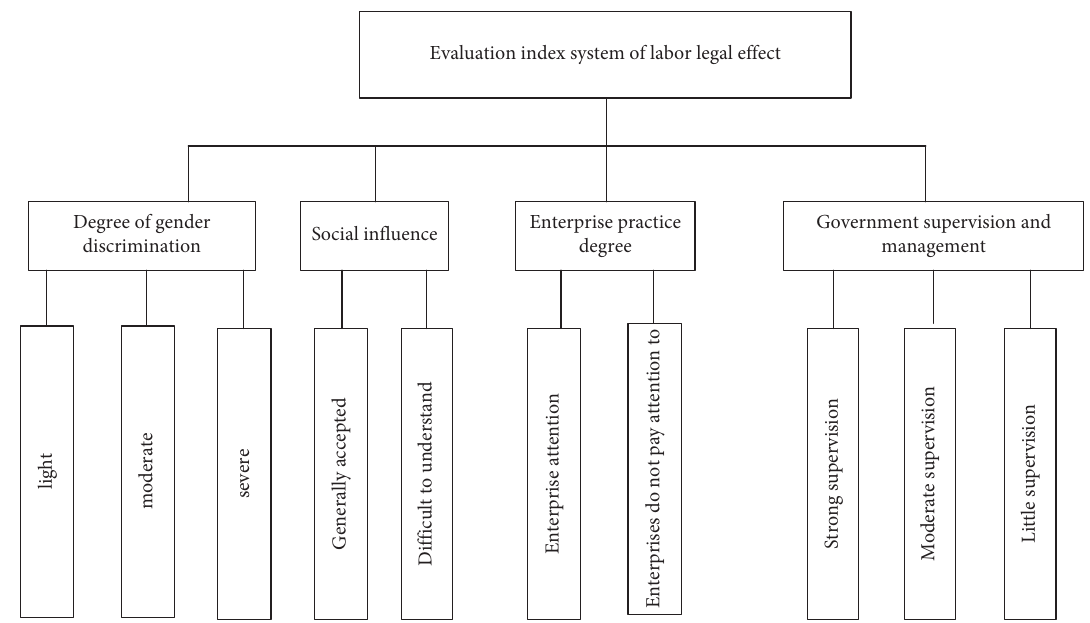
Figure 1: Schematic diagram of labor legal effectiveness evaluation system against gender